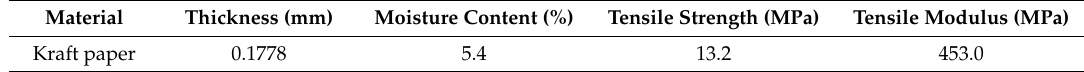
Figure 1. The idealized structure of honeycomb core: ( a ) Traditional hexagonal honeycomb, ( b ) Taiji honeycomb. Table 2. Paper characteristics to fabricate the honeycomb core.